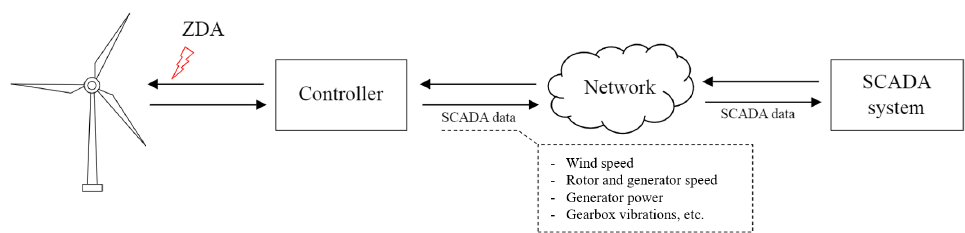
Figure 3. Schematic of remotely monitored and controlled wind turbine systems subject to zero- dynamics attacks. ZDA—zero-dynamics attack; SCADA—supervisory control and data